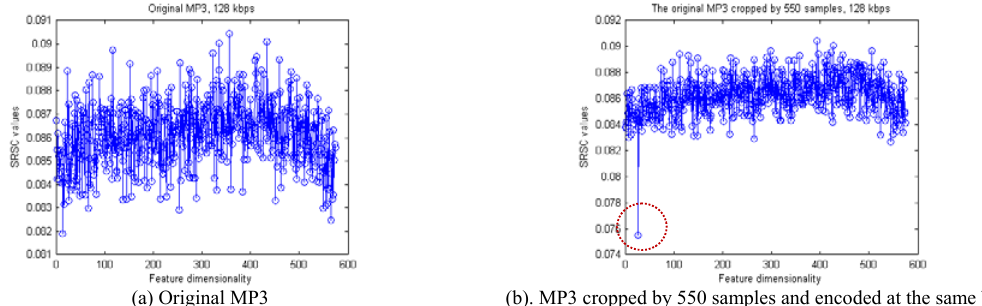
(a) Original MP3 (b). MP3 cropped by 550 samples and encoded at the same bit rate Figure 5. SRSC features of original (a) and manipulated MP3 files